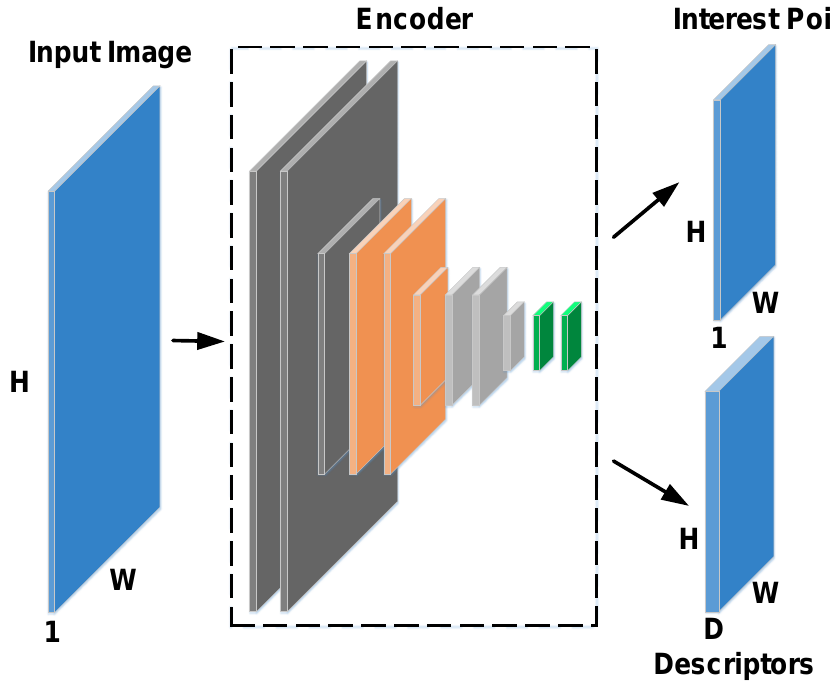
Figure 2. SuperPoint network